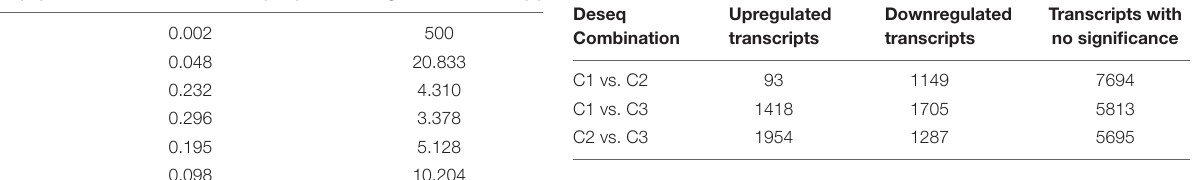
different differential expression combinations obtained from the EdgeR program. Deseq